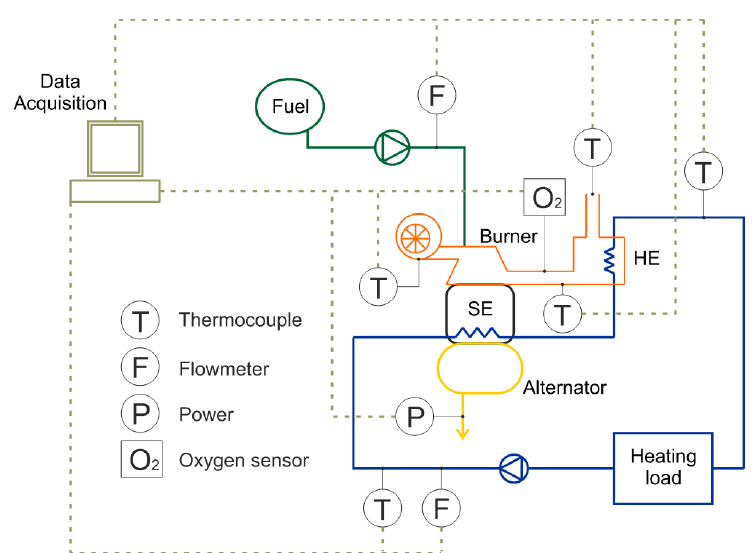
Figure 1. Data acquisition from different sensors in the experimental